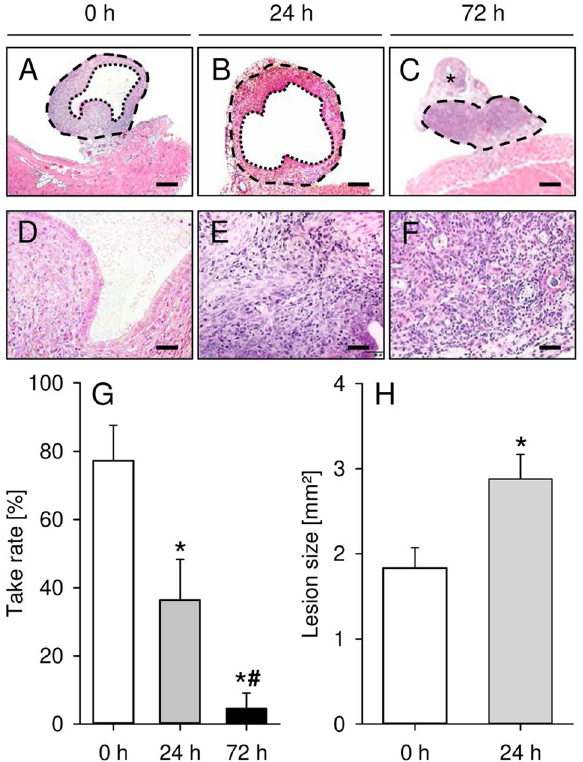
Figure 3. ( A – F ) HE-stained sections of endometriotic lesions (broken lines = borders; dotted lines = cyst- like dilated endometrial glands; asterisk = suture) on day 28 after surgical induction by fixation of freshly isolated (0 h; A , D ) as well as 24-h- ( B , E ) and 72-h-precultivated ( C , F ) uterine tissue samples from C57BL/6- TgN(ACTB-EGFP)1Osb/J donor mice to the peritoneal wall of C57BL/6J recipient mice. Scale bars: ( A – C ) = 200 µm; ( D – F ) = 35 µm. ( G , H ) Take rate ( G , %) and lesion size ( H , mm 2 ) of endometriotic lesions on day 28 after transplantation of freshly isolated (0 h; white bars; n = 10–11) as well as 24-h- (grey bars; n = 6–11) and 72-h-precultivated (black bars; n = 11) uterine tissue samples from C57BL/6-TgN (ACTB-EGFP)1Osb/J donor mice to the peritoneal wall of C57BL/6J recipient mice. Mean ± SEM; *P < 0.05 vs. 0 h; # P < 0.05 vs. 24